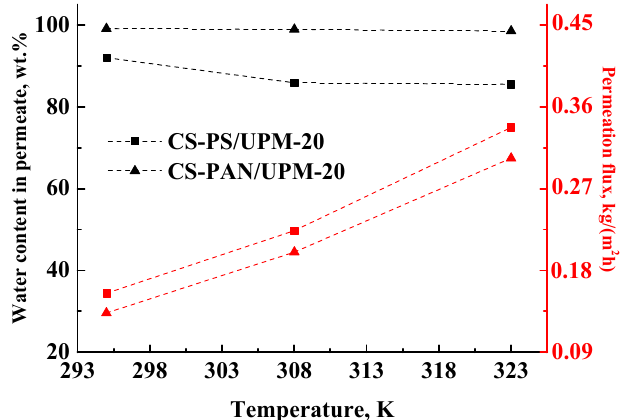
Figure 8. The dependence of water content in permeate and permeation flux on the temperature (295, 308 and 323 K) in pervaporation of an azeotrope THF-water mixture (5.7 wt. % water) by composite CS-PAN and CS-PS membranes.